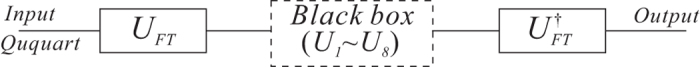
Quantum circuit to realize the permutation algorithm.UFT denotes the Fourier transformation. The black box contains all the eight permutation operators in the algorithm and  is the inverse Fourier transformation.